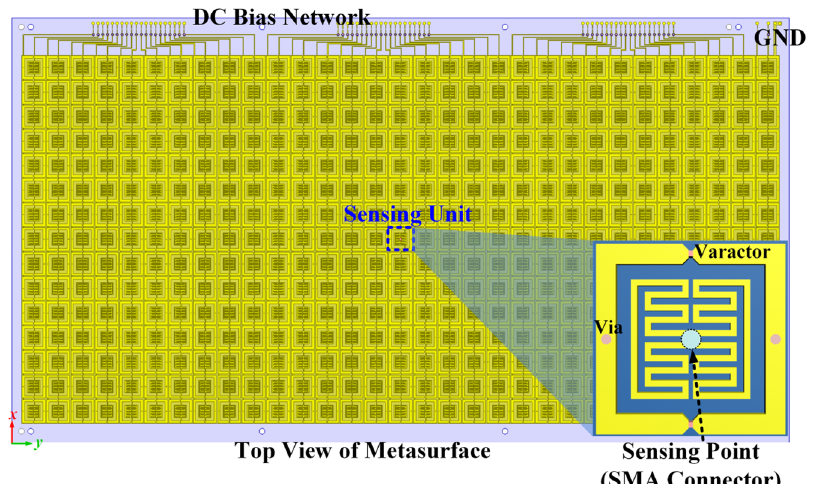
Figure 3: Top view of the intelligent metasurface with frequency sensing and the bias network. The central unit (inset) is sensing the incident wave and is connectedwith